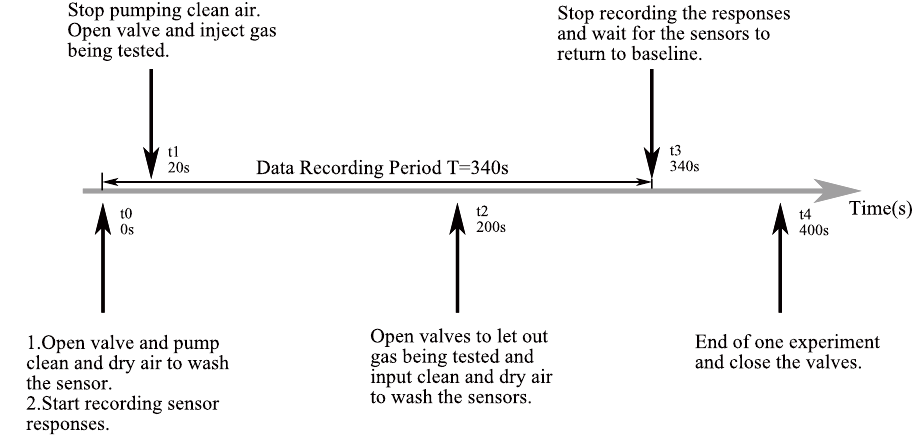
Figure 4. Experiment process for one single